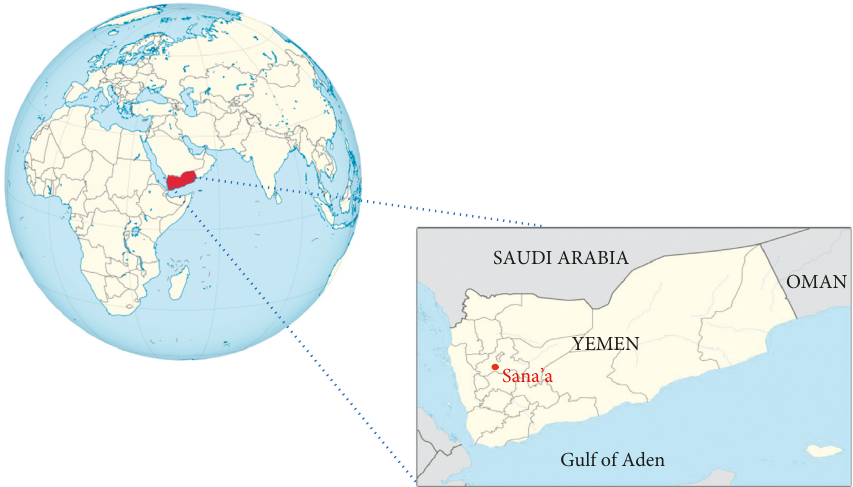
Figure 1: Map of Yemen showing Sana’a